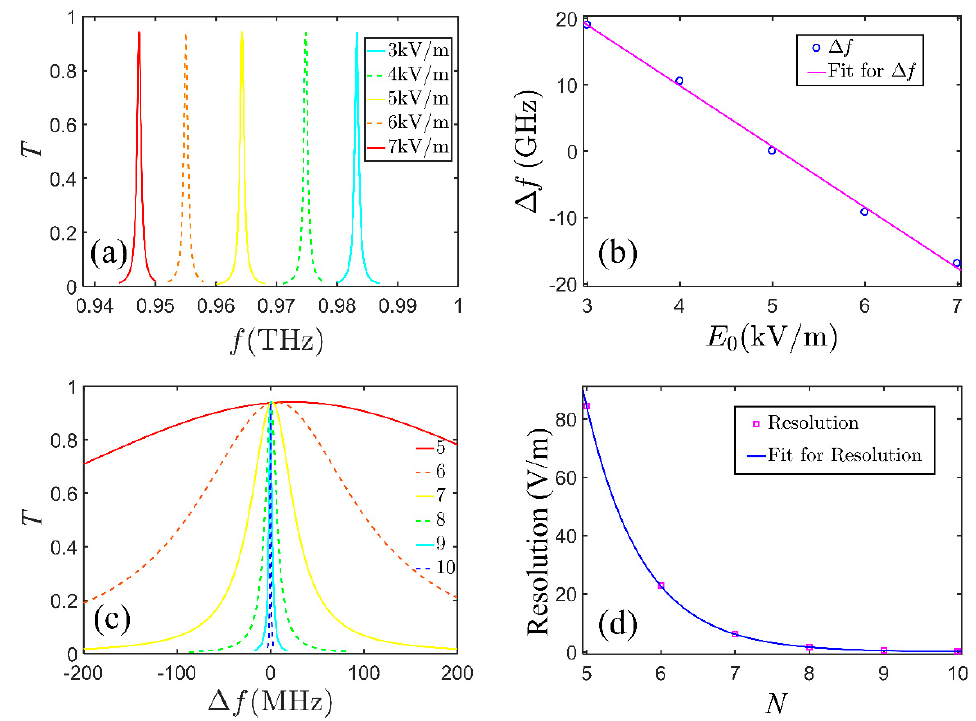
Figure 5. Frequency shift of the defect mode and its sensing characteristics. ( a ) The defect mode moves to a lower frequency as the electric field intensity increases. ( b ) The best fitting curve for the shifted frequency (the circles) of the transmitted peak under di ff erent electric field intensities exhibits high sensitivity for electric fields. ( c ) The transmitted peak gets narrower when the number of periods increases with E 0 = 5 kV / m. ( d ) The resolution (the squares) and its best fitting curve indicate that the resolution can be improved by increasing the number of periods.